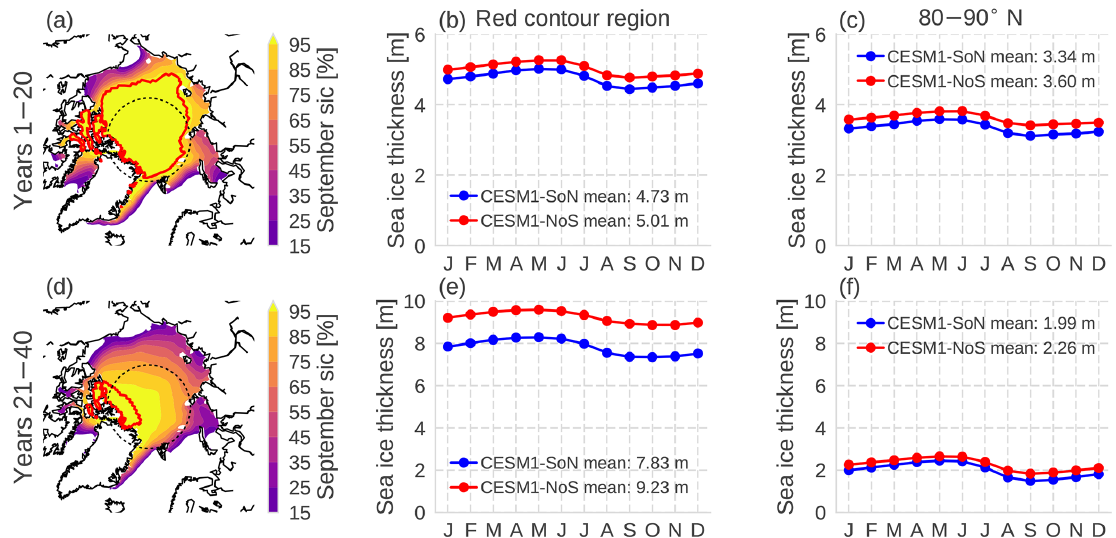
Figure 4. (a) CESM1-SoN September mean sea ice concentration over years 1–20 in 1pctCO2; the black dashed line is 80 ◦ N and the red contour encloses the region within which the mean sea ice concentration exceeds 80% in all calendar months for both CESM1-SoN and CESM1-NoS. (b) Mean thickness within the red contour for years 1–20; (c) mean thickness poleward of 80 ◦ N for years 1–20. Panels (d) – (f) are like (a) – (c) but for years 21–40.